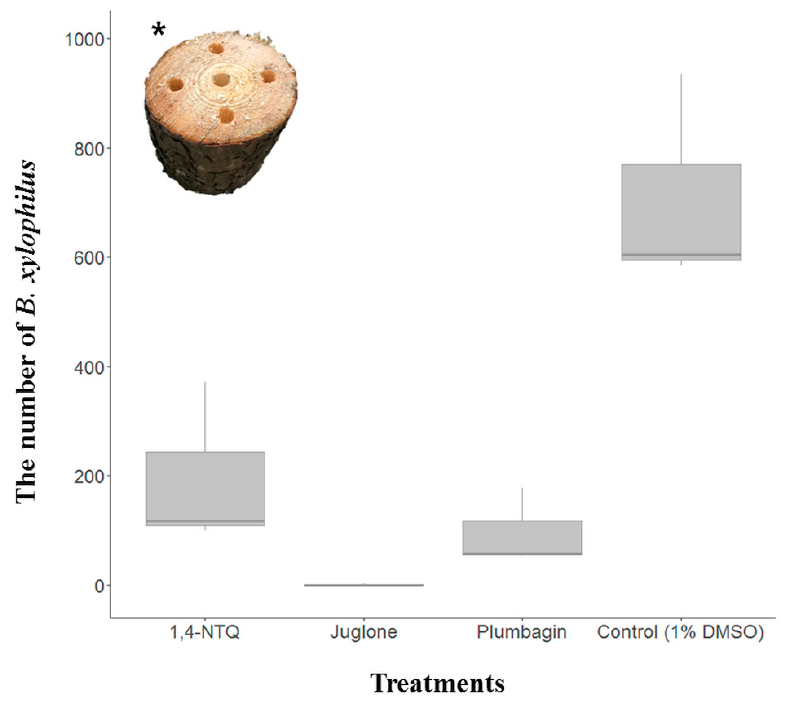
Figure 2. Semi ‐ in vivo assay for nematicidal activities of three naphthoquinones against Bursaphelenchus xylophilus. * Picture of the tested pine